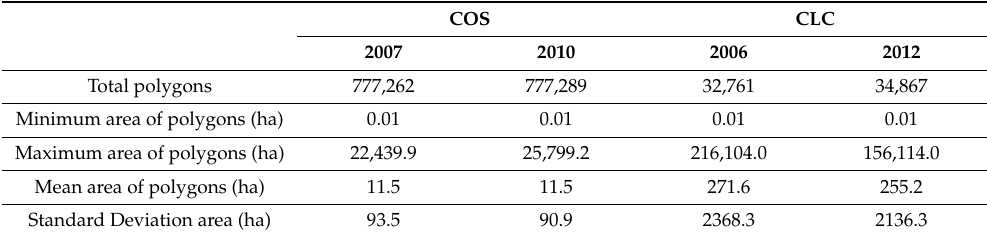
Table 2. Descriptive statistics of LUC GI datasets (vector) after the clip and compatibility by the Official Administrative Map of Portugal (CAOP) 2016 (LUC data obtained by COS and CLC).